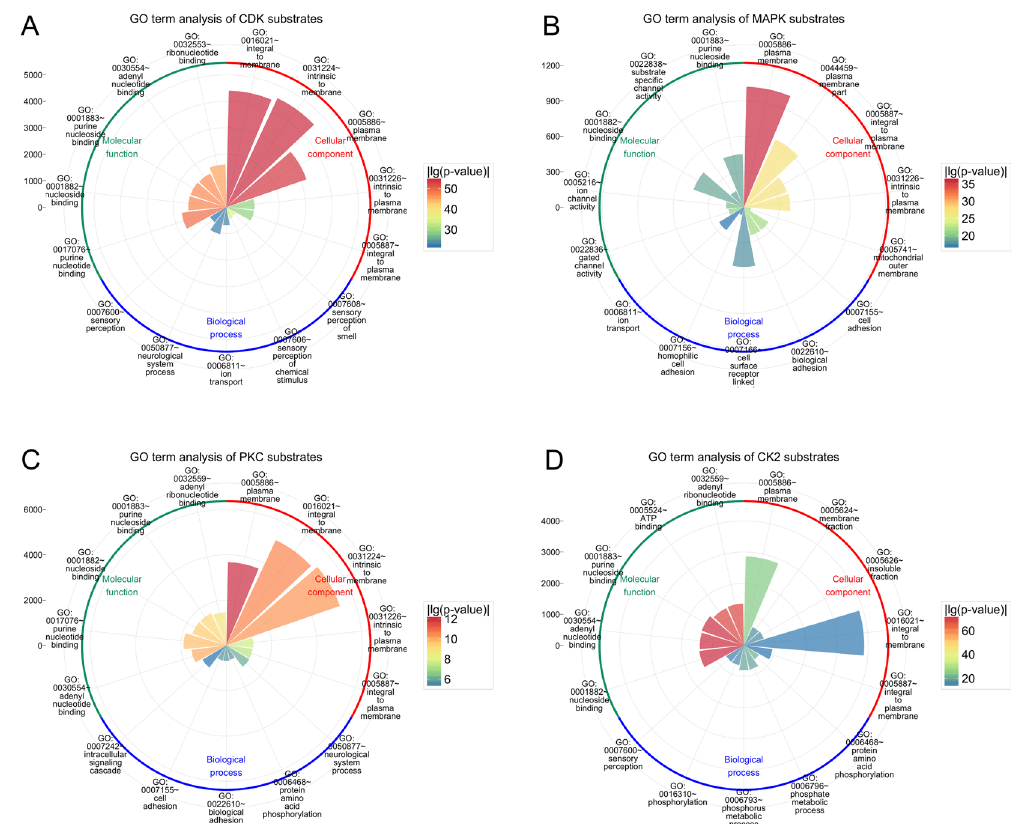
Figure 5. Functional enrichment analysis of the predicted substrates of four different kinases at the proteome level, in terms of three major categories, i.e. cellular component (GO_CC), biological process (GO_BP) and molecular function (GO_MF). For each GO category, the top five significantly enriched GO_CC, GO_BP and GO_MF terms are displayed. ( A ) CDKs; ( B ) MAPKs; ( C ) PKC, and ( D )